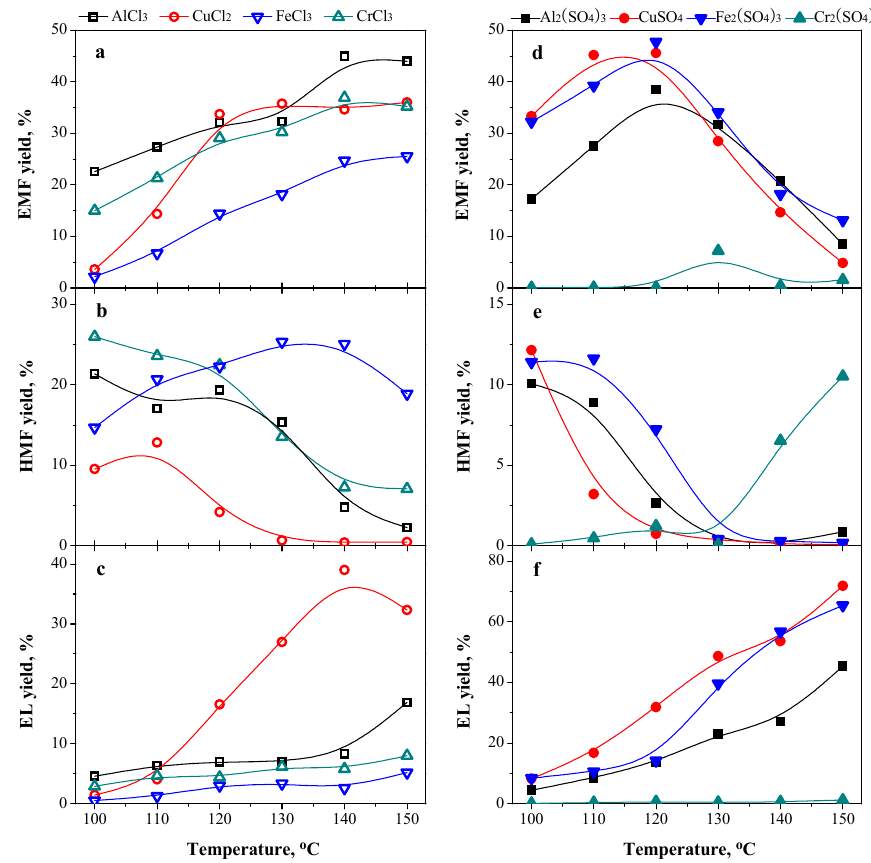
Figure 1. Effect of reaction temperature on the conversion of fructose in ethanol medium over various metal salts. ( a ) EMF yield for metal chloride catalysts; ( b ) HMF yield for metal chloride catalysts; ( c ) EL yield for metal chloride catalysts; ( d ) EMF yield for metal sulfate catalysts; ( e ) HMF yield for metal sulfate catalysts; ( f ) EL yield for metal sulfate catalysts. Reaction conditions: 0.2 mol/L fructose in ethanol; metal salt dosage of 0.02 mol/L; reaction time of 10 h.